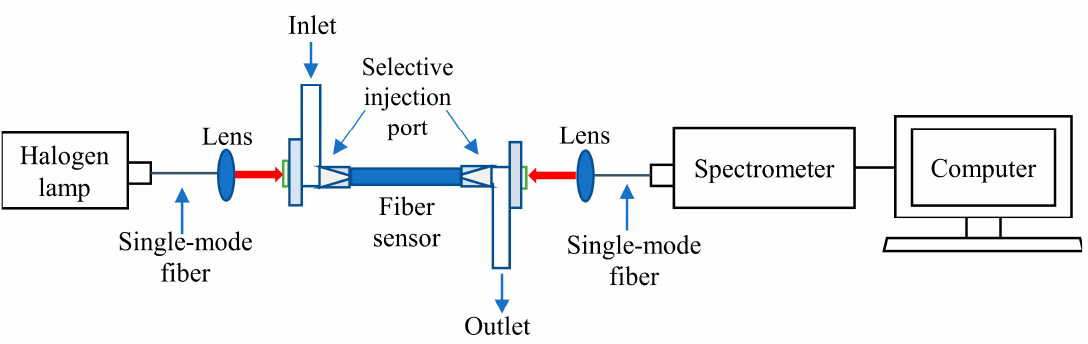
Figure 2. The system schematic designed for the experiment of the proposed sensor. The light path is constructed by the single ‐ mode fiber (SMF) and the lens.